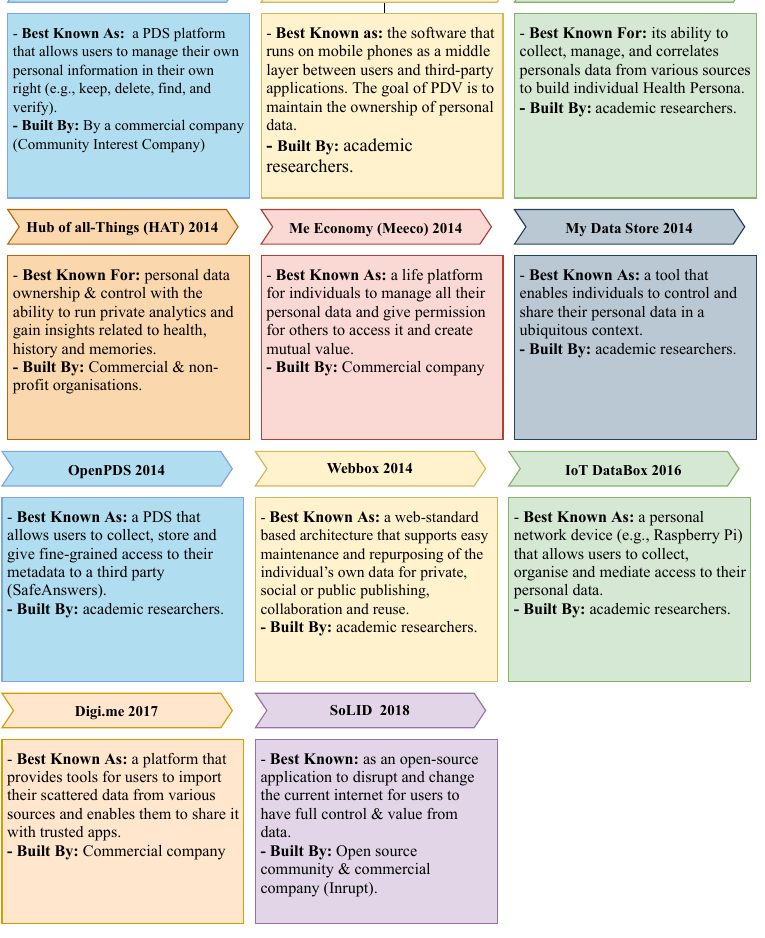
Figure 3. The evolution of the personal data